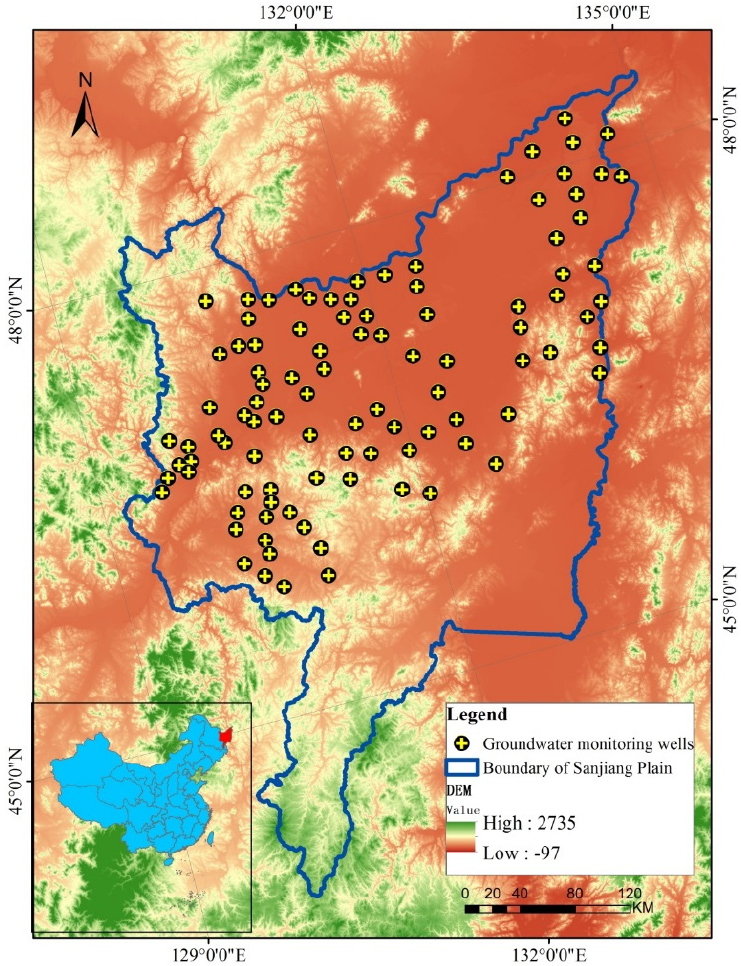
Figure 1. Geographical location of the Sanjiang Plain in Heilongjiang Province, northeast China, and the groundwater monitoring well sites used in this